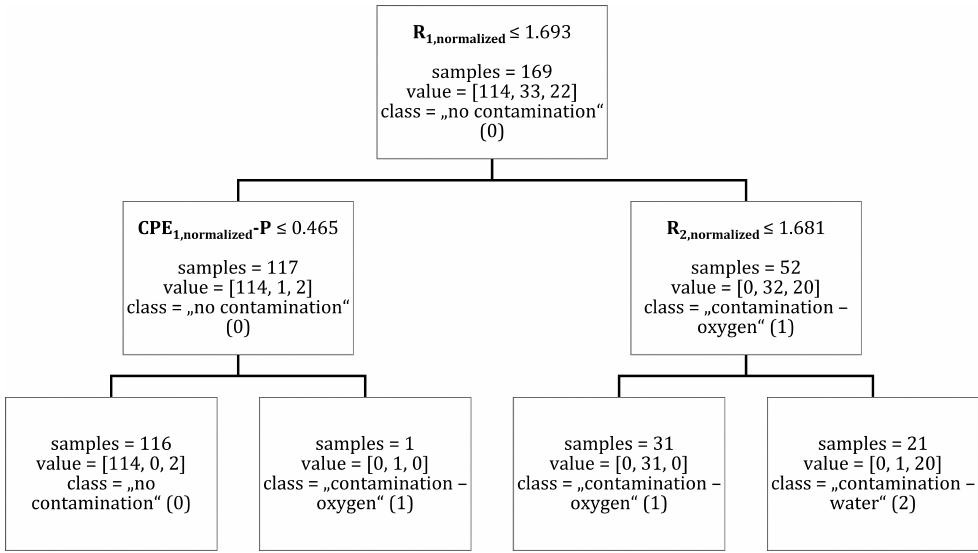
Figure A3. The classification of data points into the classes “no contamination”, “contamination— oxygen” and “contamination—water” for a decision tree of depth = 2. Brackets indicate (“no contamination” (0), “contamination—oxygen” (1), “contamination—water”